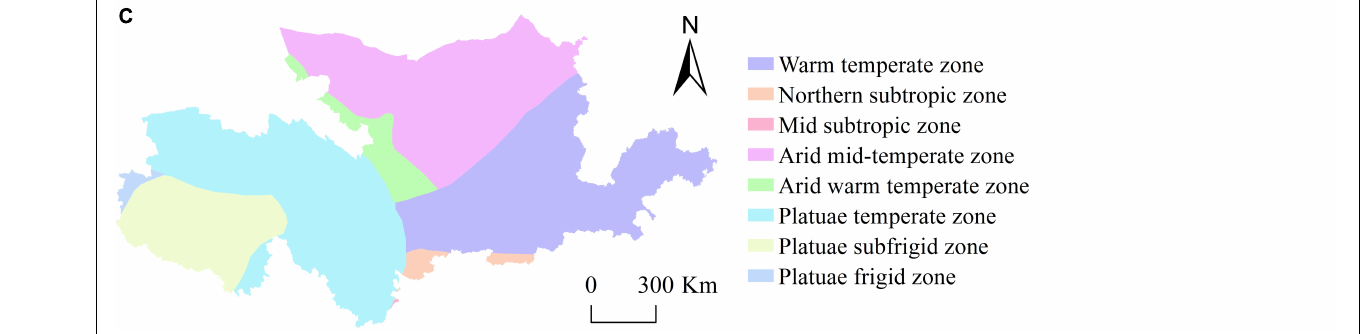
FIGURE 2 | Regional delineation of the study area. (A) Administrative zoning; (B) eco-geographical zoning; (C) agricultural natural zoning.